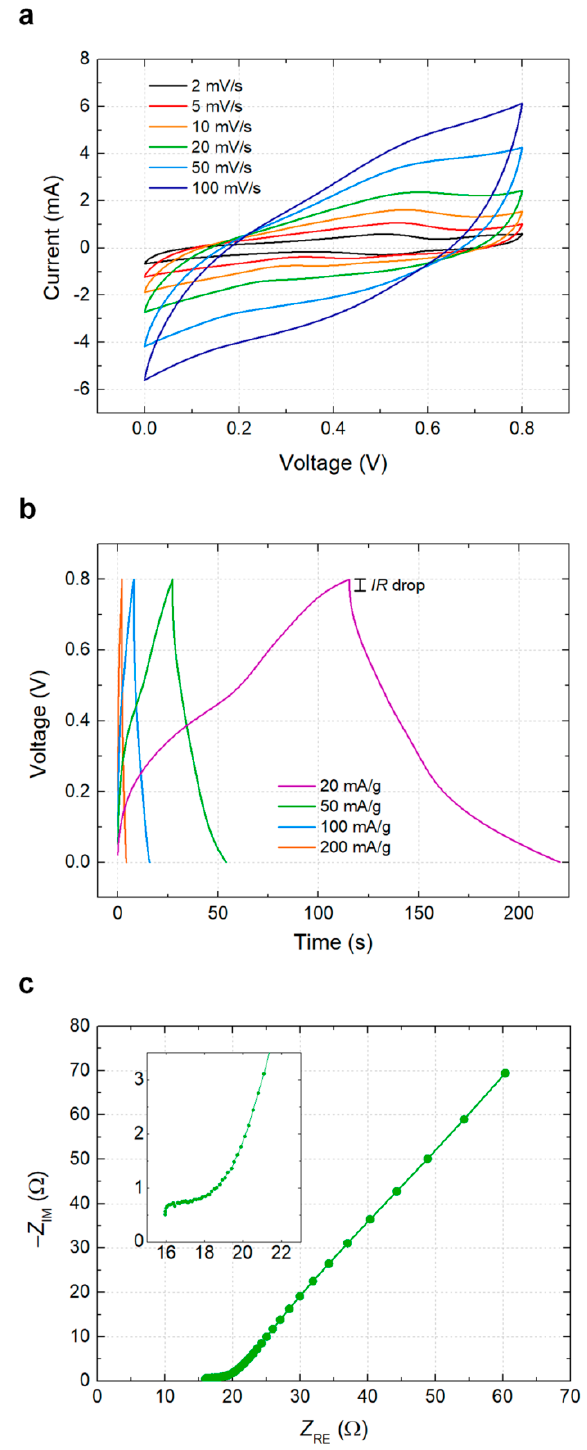
Figure 3. Electrochemical analysis of the printed supercapacitor with PVDF-LiClO 4 GPE. ( a ) Cyclic voltammetry results at various scan rates. ( b ) Galvanostatic charge and discharge results at various current densities. ( c ) Electrochemical impedance spectroscopy results.